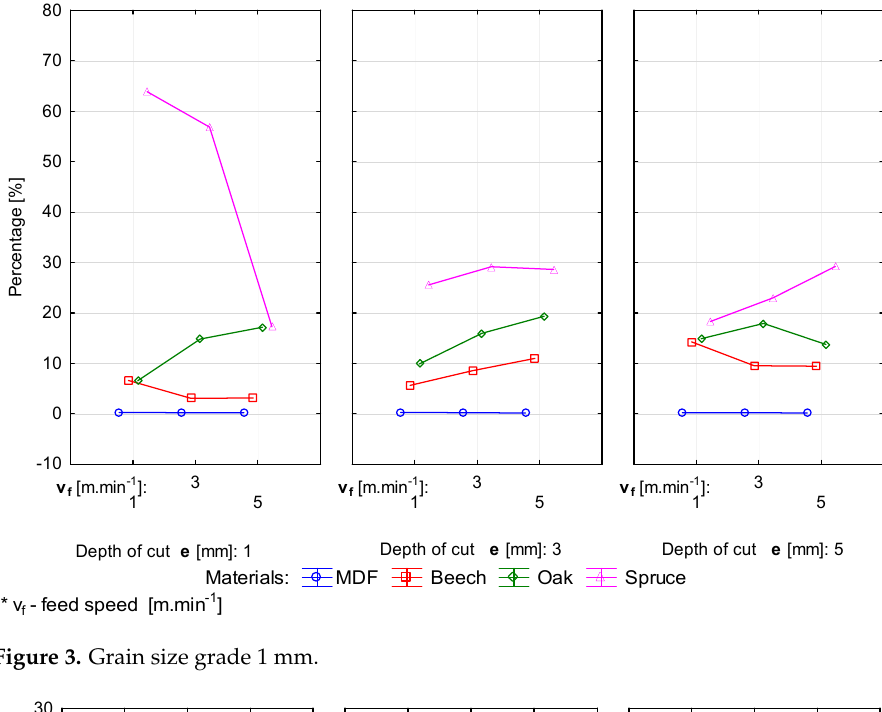
Figure 3. Grain size grade 1 mm.